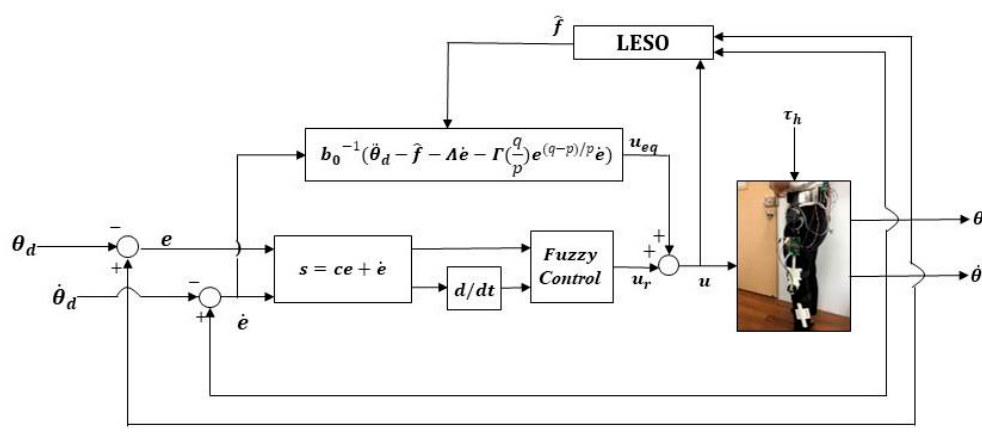
Figure 5. Control structure of LESO-based